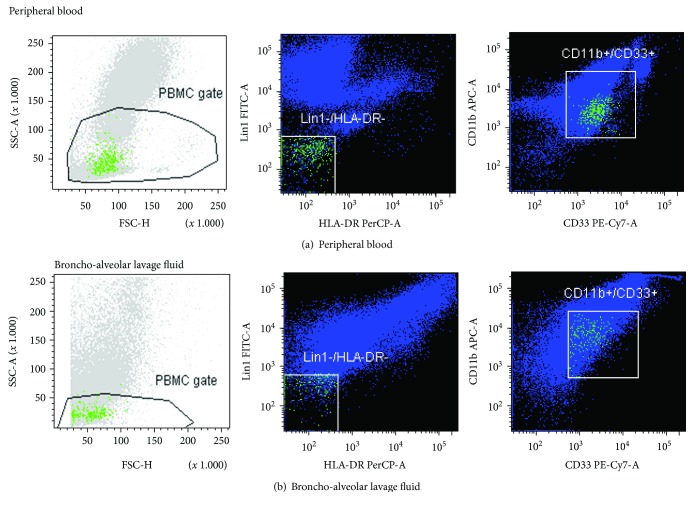
Evaluation of MDSC immunophenotype using a flow cytometer. Scattergrams showing MDSC cells in peripheral blood (a) and in BALF (b). The MDSC immunophenotypic pattern was defined as Lin-1neg/low/HLA-DRneg/low/CD33pos/CD11bpos.